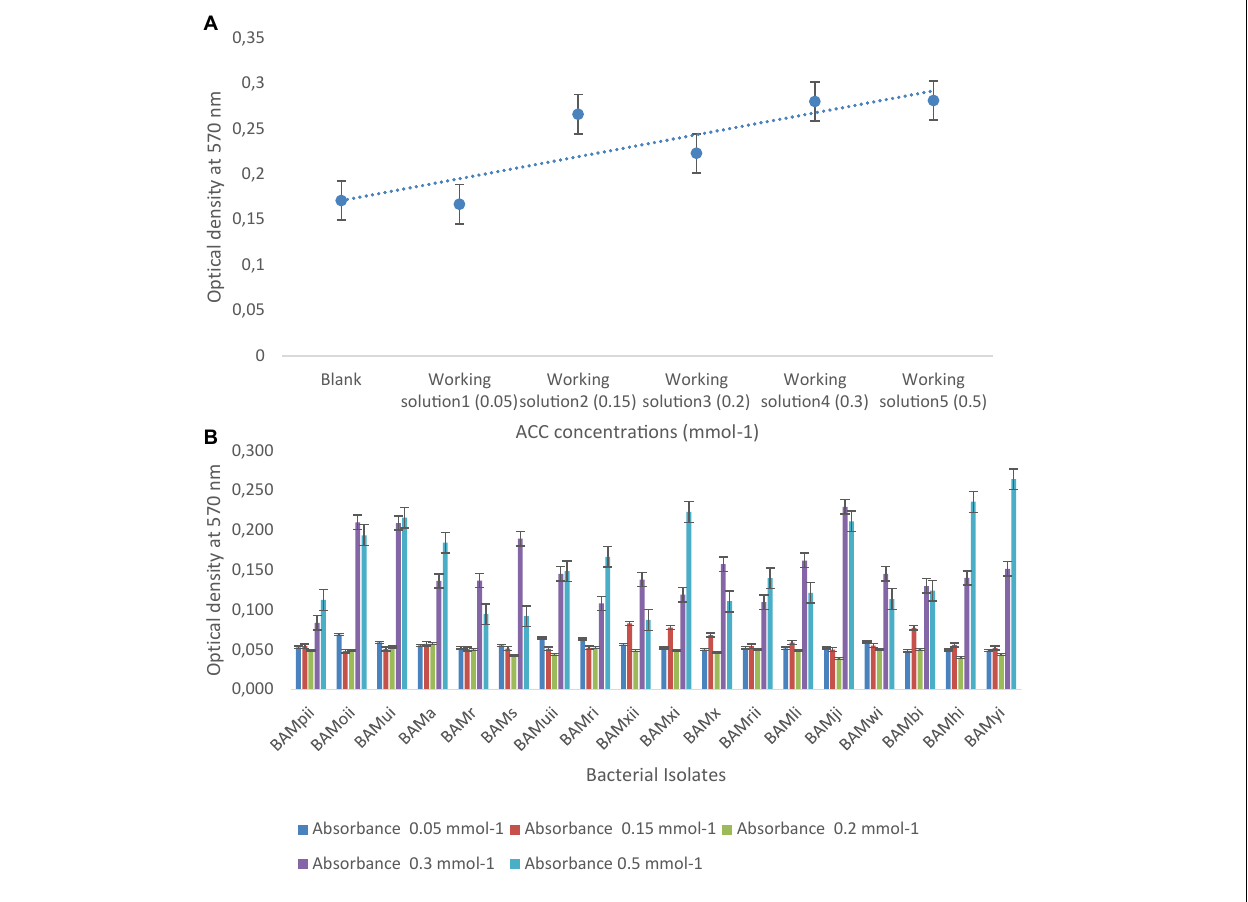
FIGURE 7 | (A) The standard curve of ACC concentrations, ranging from 0.05 to 0.5 mmol - 1 determined by the 96-well PCR-plate ninhydrin assay ( y = 0.0242x + 0.1467, R 2 = 0.7364). Each data point represents the mean from triplicate determinations, and the error bar represents the standard error ACC, 1-aminocyclopropane-1-carboxylate. (B) Absorbance of bacterial isolates at different concentrations of